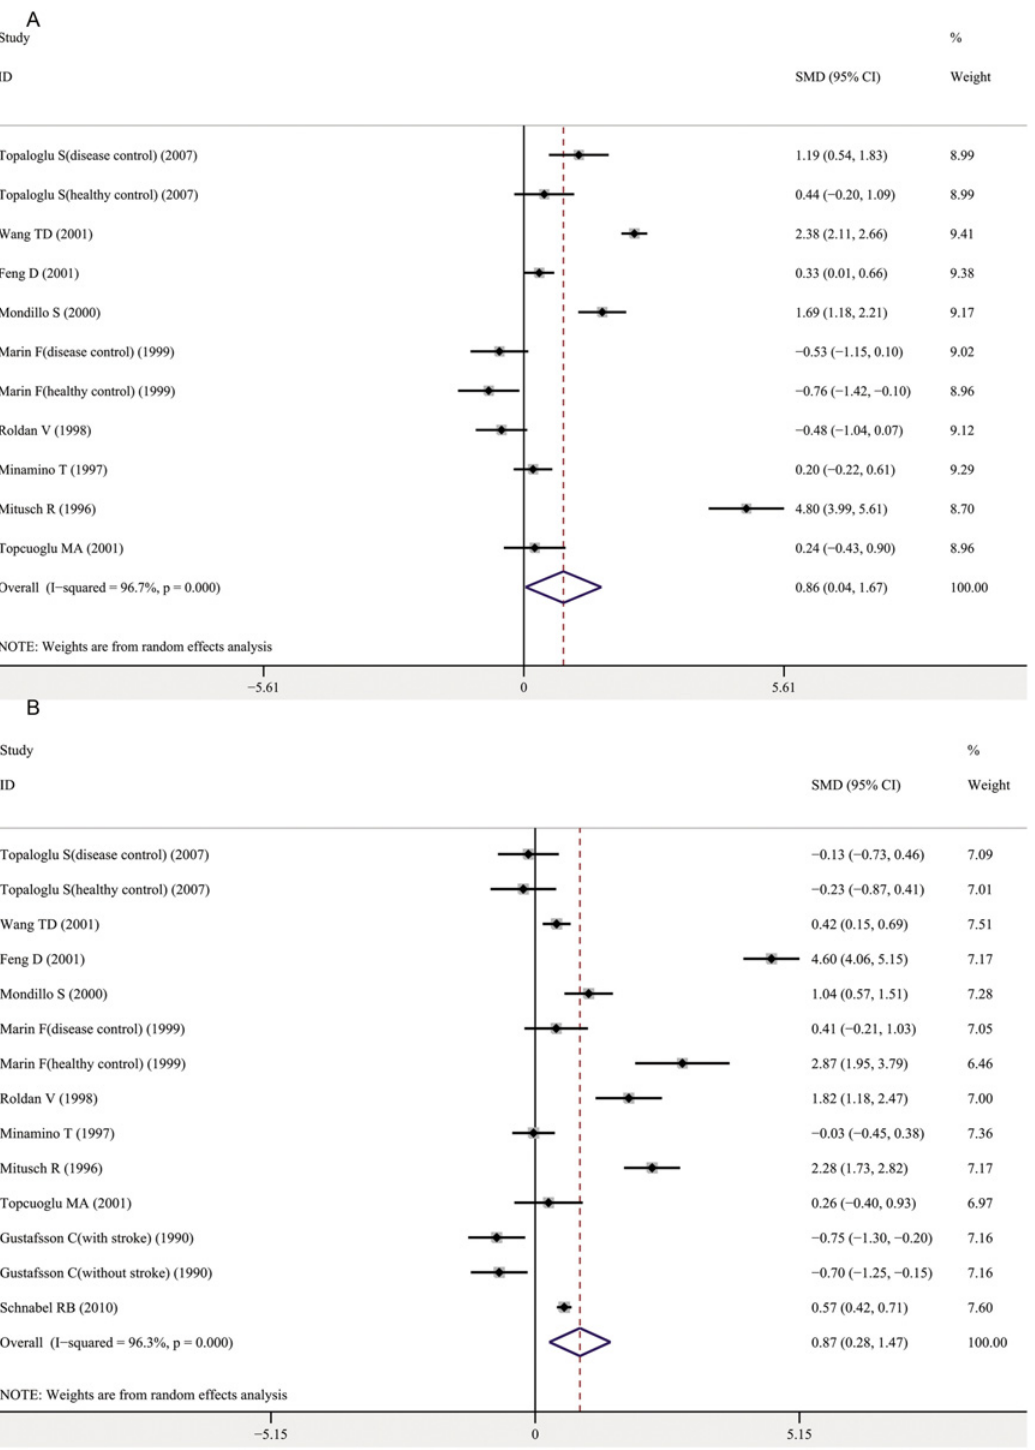
Fig 4. Association between fibrinolytic function makers and AF. A. Tissue-type plasminogen activator and AF; B. Plasminogen activator inhibitor-1 and AF. Forest plots of SMD and overall SMD with 95% CI between AF cases and controls. Black diamonds indicate the SMD, with the size of the square inversely proportional to its variance, and horizontal lines represent the 95% CI. The pooled results are indicated by the black hollow diamond. AF, atrial fibrillation; tPA, tissue-type plasminogen activator; PAI-1, plasminogen activator inhibitor-1; SMD, standardized mean difference.